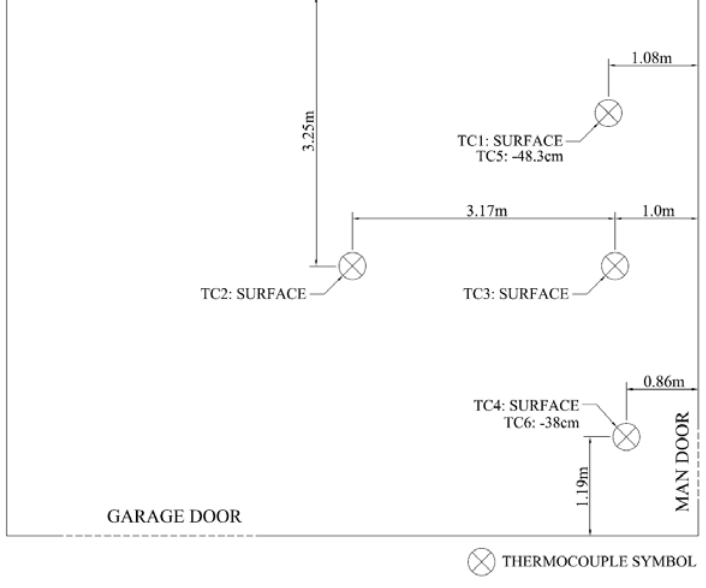
Figure 9. Thermocouple arrangement on sand ‐ bed thermal storage.